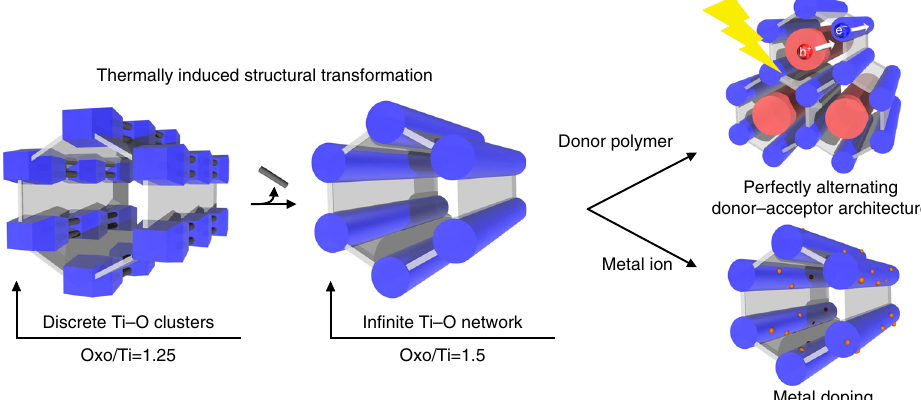
Fig. 1 Structural transformation of and modi fi cation to MIL-177 MOFs. A thermally induced structural transformation of the discrete Ti 12 O 15 cluster SBUs linked by bridging formates in MIL-177-LT structure (left) to 1D in fi nite (Ti 6 O 9 ) n nanowires in MIL-177-HT structure (middle) is observed with an increase of the condensation degree from 1.25 to 1.5. Introduction of conductive polythiophene into the pores of MIL-177-HT gives rise to a perfectly alternating donor – acceptor architecture for photoconduction application (right top). Other metal species can be doped into the inorganic unit of MIL-177 to introduce modi fi cation to its properties